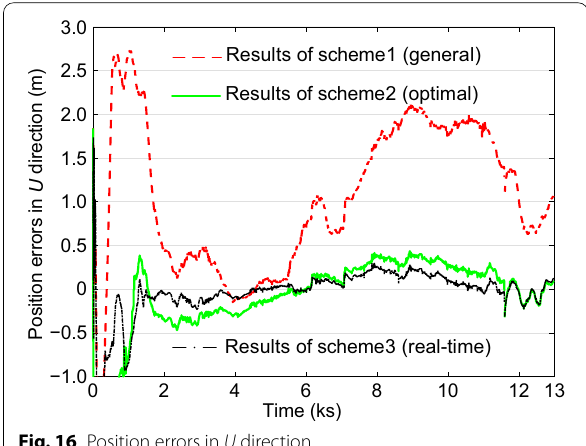
Fig. 14 Position errors in E direction